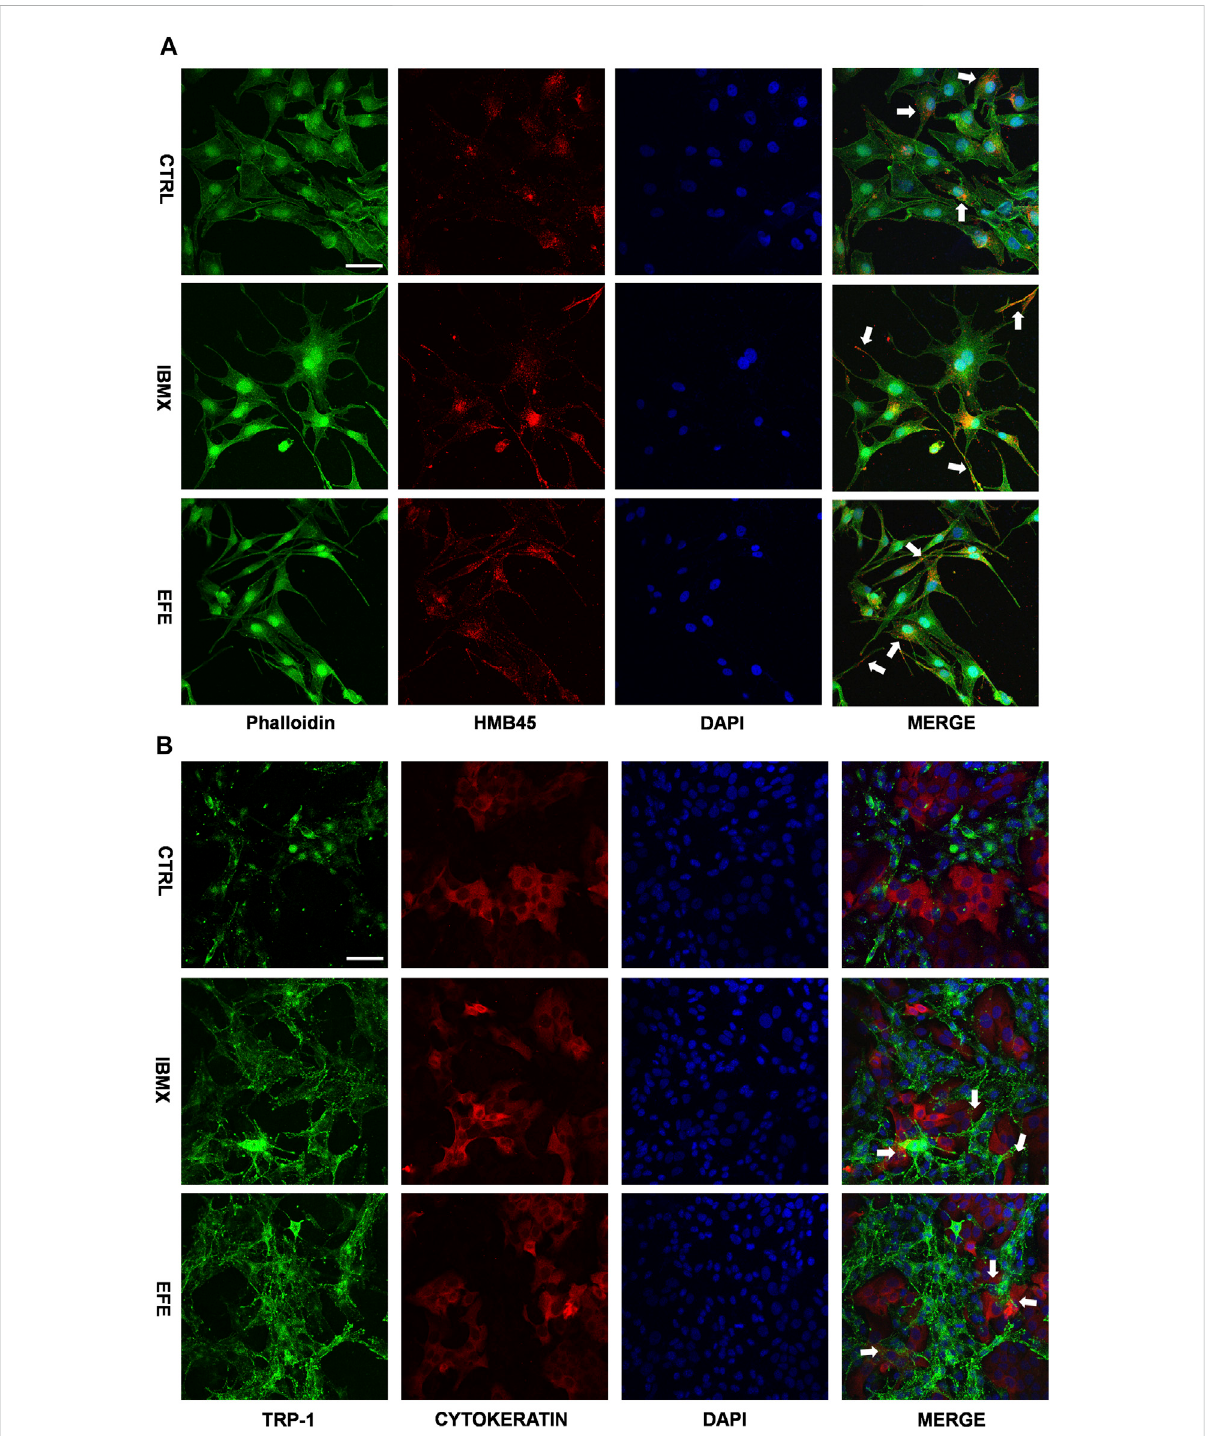
FIGURE 7 EFE raises melanosome number, promotes melanosome maturation/transferring in co-cultured melanocytes and keratinocytes to pigmentation. (A) Representative images of immuno fl uorescence staining in SK-MEL-28 cells (red: HMB45, green: phalloidin, blue: DAPI; IBMX- 100 μ M, EFE-40 μ g/ml treated for 72 h; scale bar = 50 μ m); (B) representative images of immuno fl uorescence staining in B16F10 cells and HaCaT cells co-culture (red: CYTOKERATIN, green: TRP-1, blue: DAPI; IBMX-100 μ M, EFE-40 μ g/ml treated for 72 h; scale bar = 50 μ m). For graphical representation, representative image from three independent experiments is